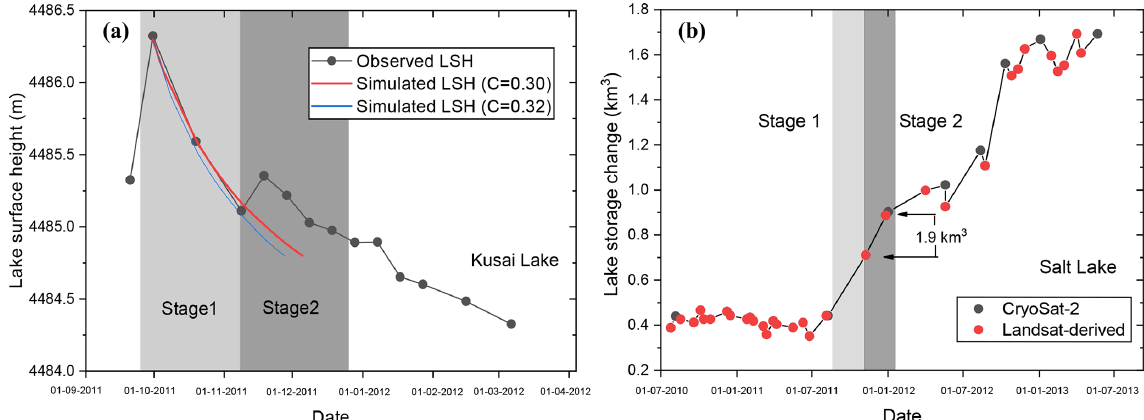
Figure 19. Changes in the water level of Lake Kusai after receiving the outburst flood from Lake Zhuonai. Stage 1 was used to determine the range of parameter C in Eq. (13). Stage 2 was used to compared the simulated lake outflow from Kusai Lake based on Eq. (13) with the water gain estimate from remote sensing of Lake Salt downstream during the same period; and (b) changes in water storage of Lake Salt derived from remote sensing using our developed method. There was 0.19km 3 of water gained in stage 2, which was comparable to the outflow estimate of Lake Kusai (0.22km 3 ) based on Eq.